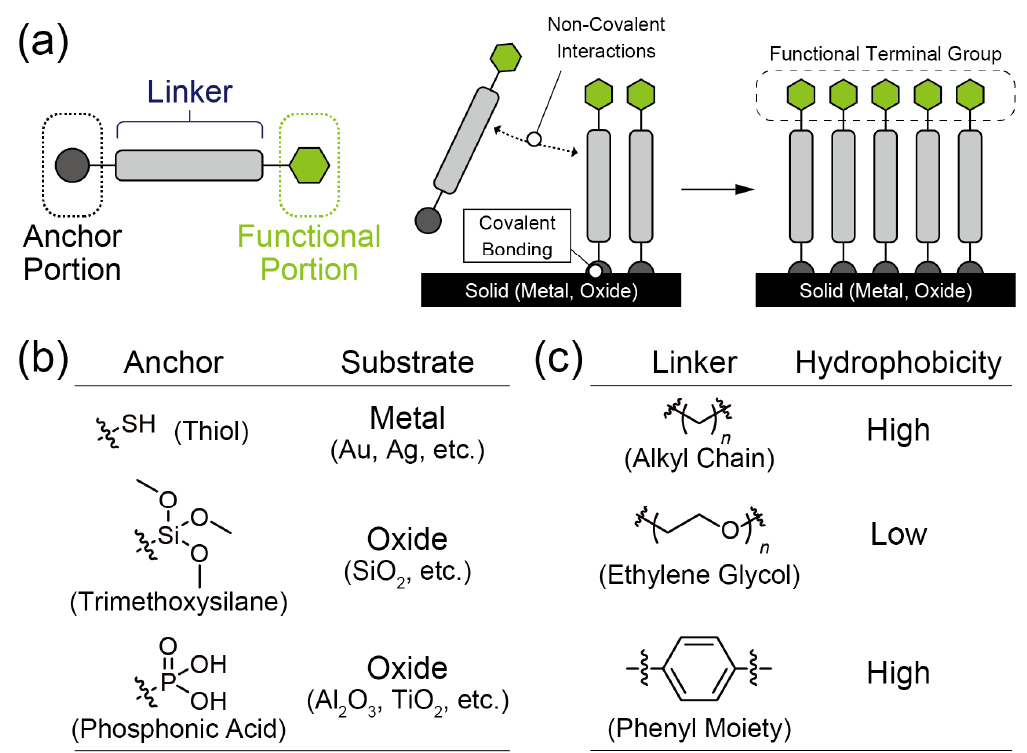
Figure 3. ( a ) Schematic representation of a SAM formation. ( b ) Example groups of the anchor portion in SAM components for the modification on various surfaces. ( c ) Typical structures of the linker portion in the SAM with the different hydrophobicity.